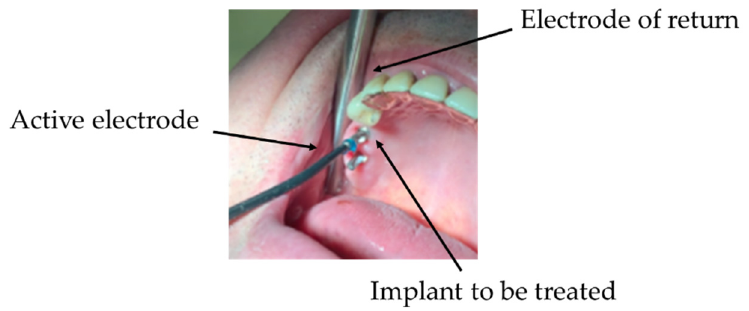
Figure 12. The electromagnetic treatment on a patient; the active electrode is screwed to the implant,